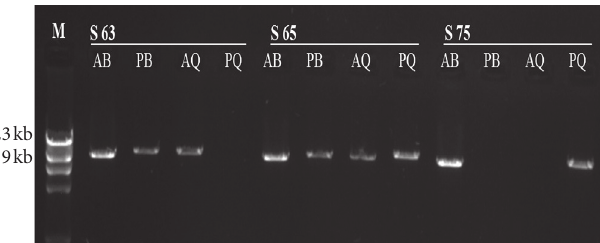
Figure 1: S-PCR analyses for FVIII intron 22 related inversion using 1% agarose gels. AB, PB, AQ, and PQ are primers related bands for samples 63, 65, and 75. The picture shows an Inv22 positive result for sample S63, a heterozygous carrier female Inv22 for sample S65, and a negative Inv22 result for sample 75. M: λ DNA HindIII ladder marker (0.1kb–23kb). S: sample